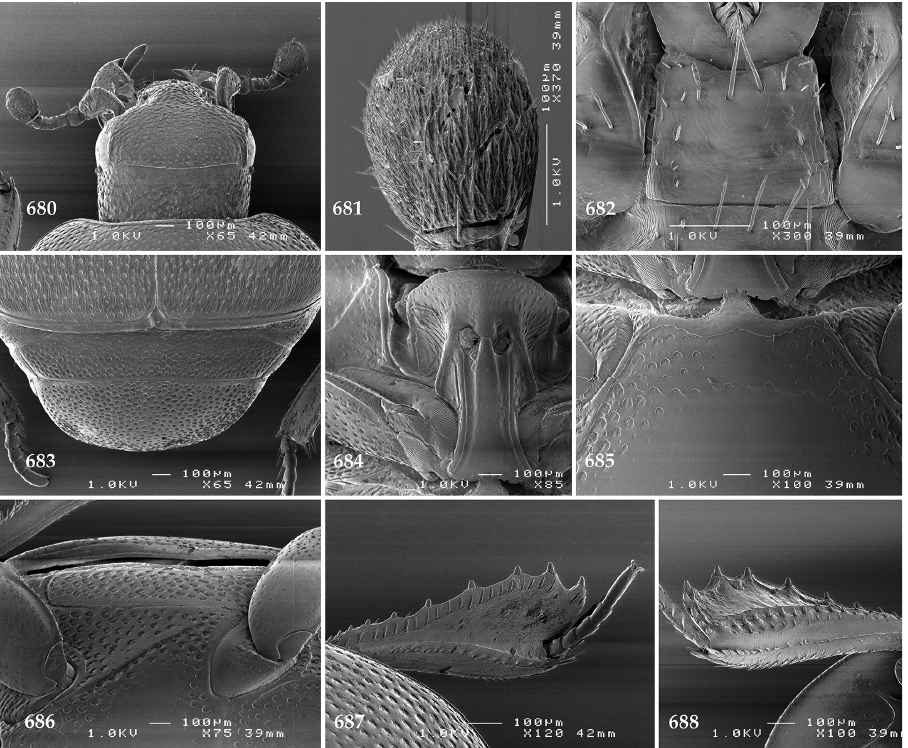
Figs 666 with 686). Intercoxal disc of first abdominal ventrite similar to that of T. kuscheli , but punctures laterally sparser and larger and medially almost smooth. Proti- bia (Fig. 687) flattened and dilated, outer margin with five very low teeth followed by 4 tiny denticles diminishing in size proximally; first two teeth approximate, separated from the second pair of teeth (which can also be approximate) by rather wide and deep gap. Fifth tooth separated likewise by wide, but by no means deep gap. Setae of outer row short, regular and sparse; setae of median row similar, but shorter and finer than those of outer row, growing in size distally; protarsal groove shallow; anterior protibial stria complete, costate; two thin, rather long tarsal denticles present apically; protibial spur short, straight, growing out from apical protibial margin; apical margin of protibia posteriorly with two or three apical denticles; outer part of posterior surface of protibia (Fig. 688) smooth, well divided from median part of posterior surface by ridge like stria; median part of posterior surface with two sparse rows of minuscule setae; posterior protibial stria complete with tightly-spaced short and stout denticles near apical margin; inner margin with double row of short setae (similar to that of T. australis , but